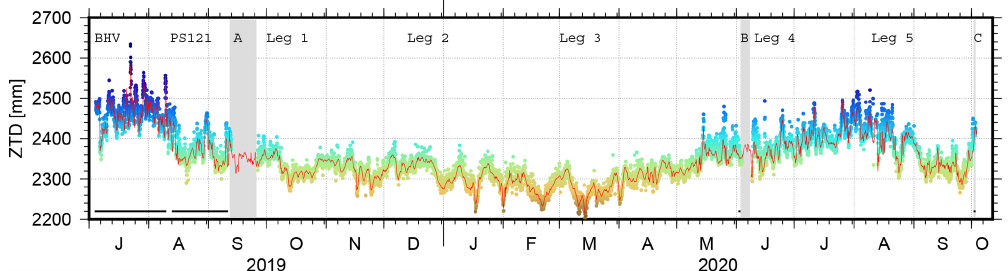
Figure 7. ZTD time series: hourly ZTD values (color coded according to the ZTD, same scale as in Fig. 6) and 3-hourly ERA5-based ZTDs (red line); the cruise parts are indicated by labels, restricted time periods are shaded in gray; horizontal black lines indicate periods for which comparisons with terrestrial GNSS stations were possible.